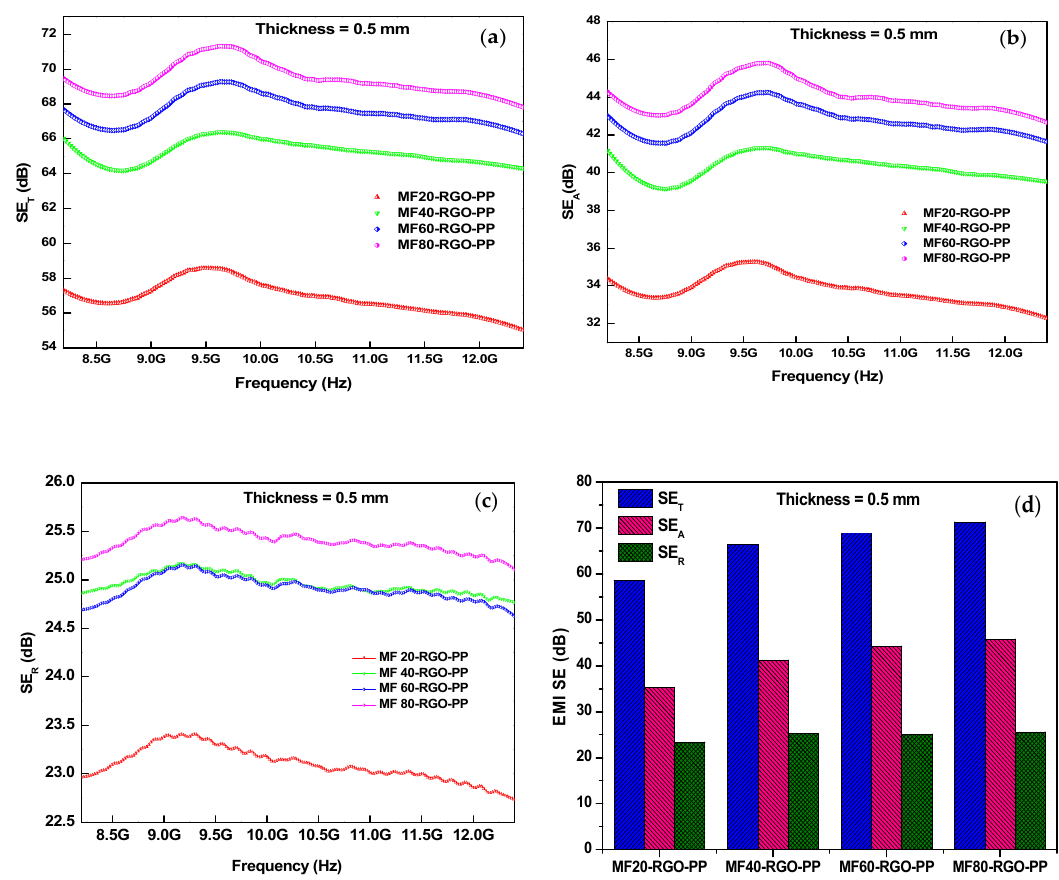
Figure 11. Electromagnetic interference (EMI) shielding effectiveness ( a ) SE T , ( b ) SE A , ( c ) SE R and ( d ) comparison plot of SE T , SE A and SE R for prepared nanocomposites MF20-RGO-PP, MF40-RGO-PP, MF60-RGO-PP and MF80-RGO-PP at a thickness of 0.5 mm.